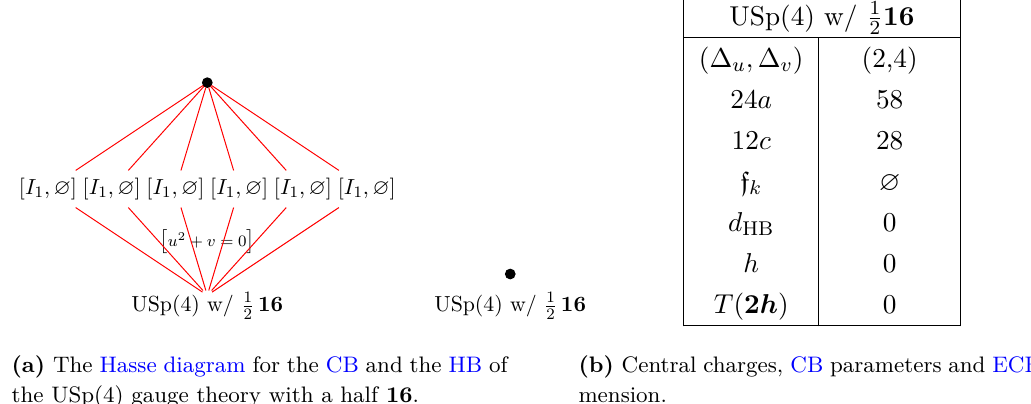
Figure 44. Information about the USp(4) N = 2 theory with a-half hypermultiplet in the 16